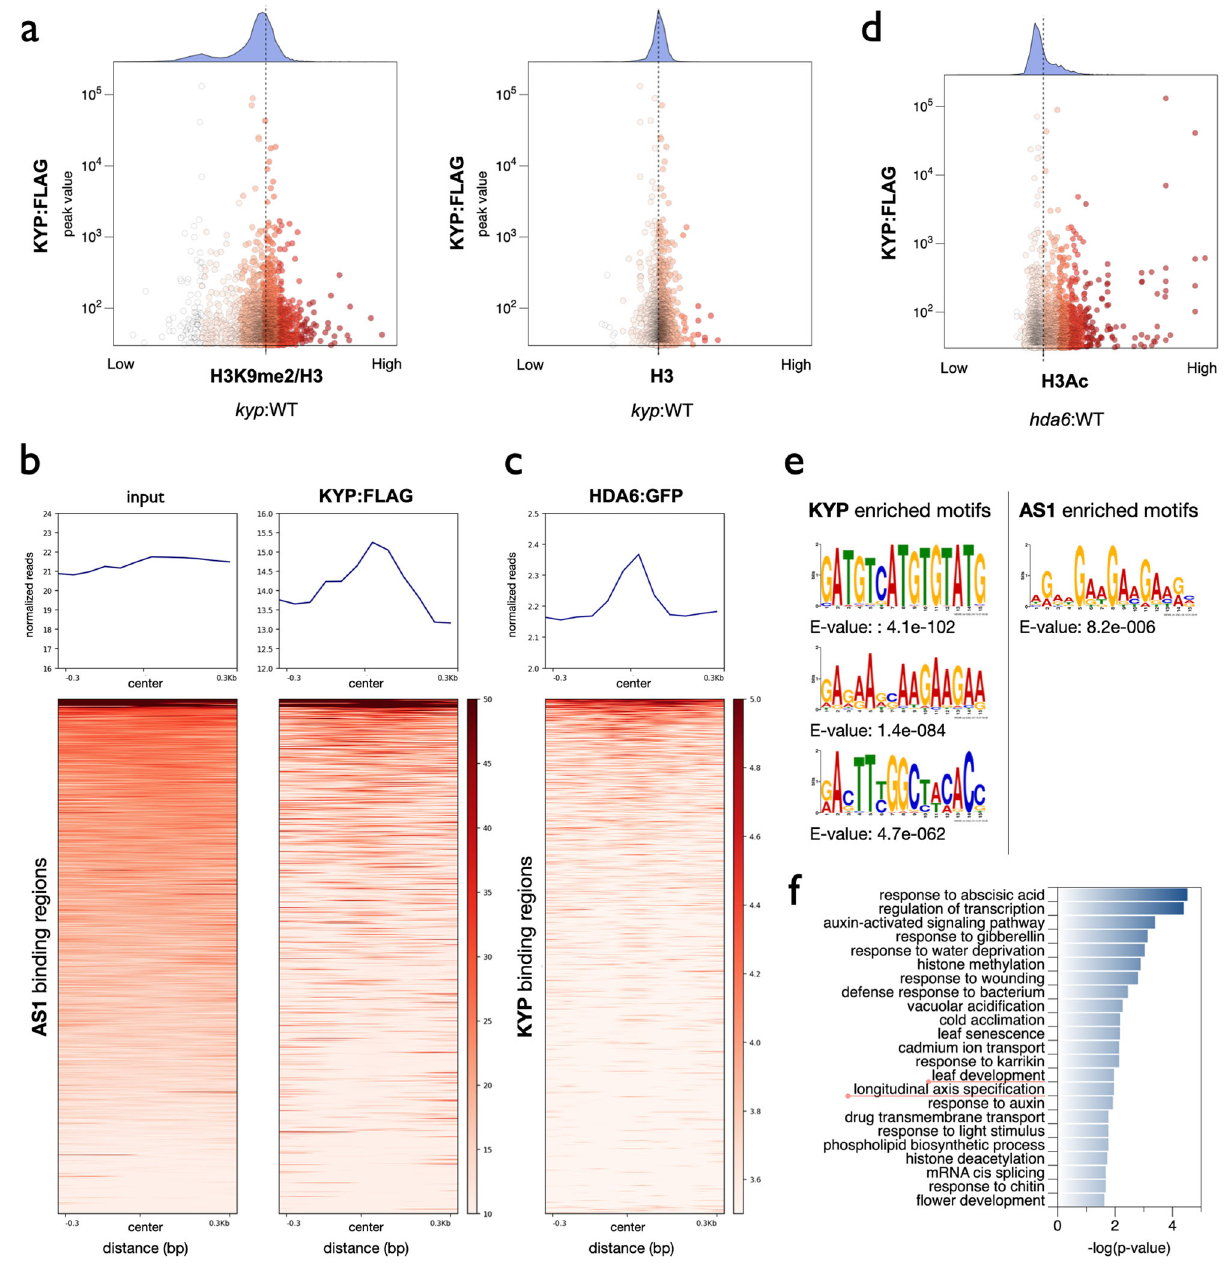
Fig. 6 KYP-targeted genomic regions are highly correlated with AS1 and HDA6. a X – Y scatter plots showing the relative enrichment of H3K9me2 ( kyp : WT) and the binding level of KYP. The value of H3K9me2/H3 indicated the relative H3K9me2 level of kyp compared to WT and normalized to H3. The dotted line indicated the average value. b , c Heat map representation of the co-occupancy of KYP with AS1 ( b ) and HDA6 ( c ) in the genome. Each horizontal line represents an AS1-( b ) or KYP-( c ) bound region, and the signal intensity is shown for KYP ( b ) or HDA6 ( c ) binding. Columns show the genomic region surrounding each AS1-( b ) or KYP-( c ) peak. Signal intensity is indicated by the shade of red. d X – Y scatter plots showing the relative enrichment of the H3Ac level ( hda6 : WT) and the binding level of KYP. The value of H3Ac indicated the relative H3Ac level of kyp compared to WT. The dotted line indicated the average value. e DNA binding motifs signi fi cantly enriched in the KYP or AS1-binding sites. f GO-BP annotation of KYP -targeted genes. Annotation terms with p -value < 0.025 were